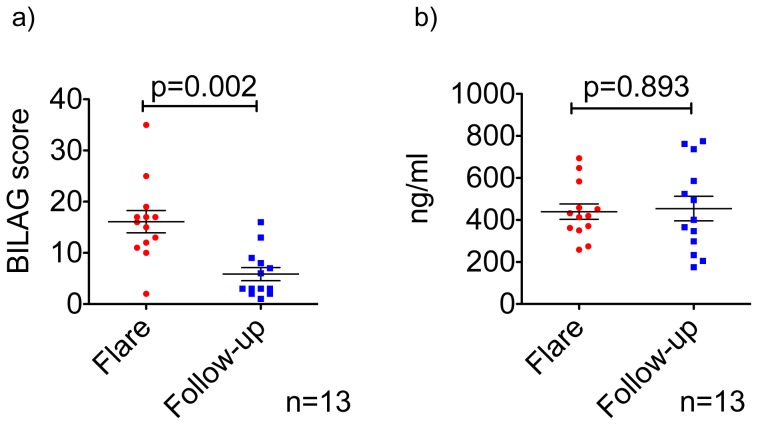
SLE disease activity score measured with the BILAG index reduces significantly over the time while total IgG levels remain the same.The British Isles Lupus Assessment Group (BILAG) index score during disease flare and the follow-up period. Figure 1a. A significant improvement is detectable over the time. Figure 1b. A level of total IgGs in patients’ blood is similar during disease flares and in the follow-up period. p<0.05 value considered significant in Wilcoxon test.